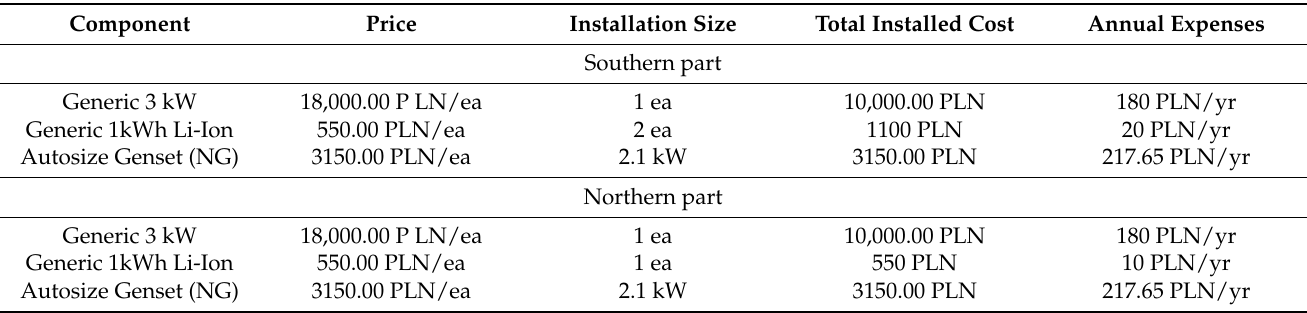
Table 4. Installation